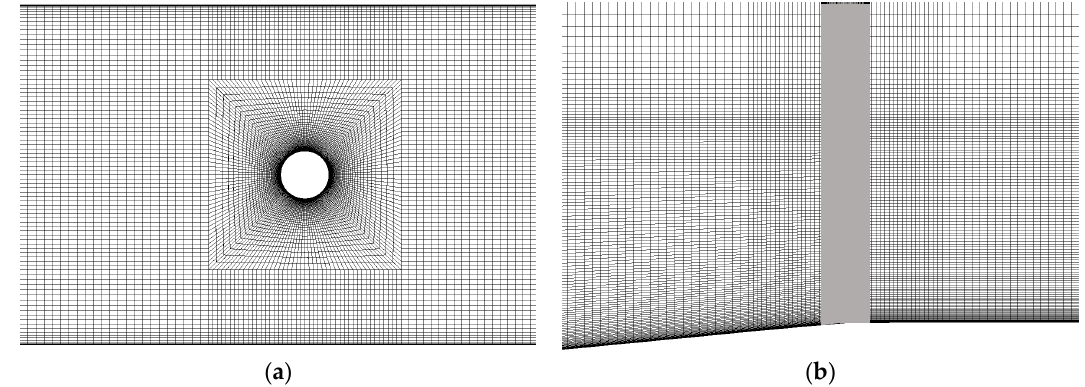
Figure 4. The plan view ( a ) and front view( b ) of the medium mesh near the vertical cylinder.